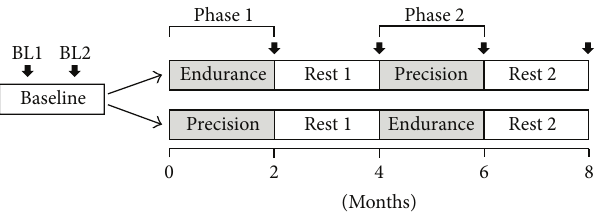
Figure 1: Experimental design. Training consisted of two months of each of Endurance and Precision Training, in a crossover design with rest periods interspersed. Participants were randomly allocated to start with either Endurance or Precision Training. Reflex and walking measures were taken twice at baseline (BL; ∼ 1 week apart) and after each training and rest period (solid vertical